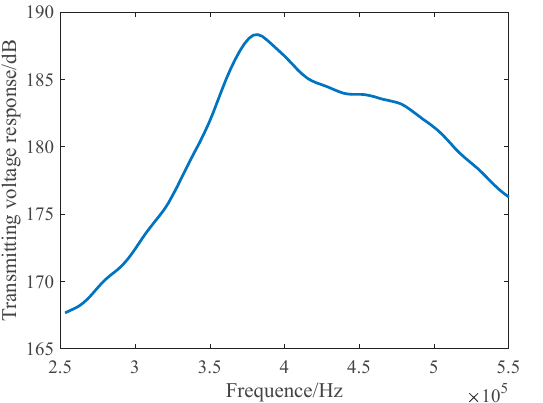
Figure 7. Transmitting Voltage Response–Frequency Curve of a Broadband Composite Array in the Matching Layer.